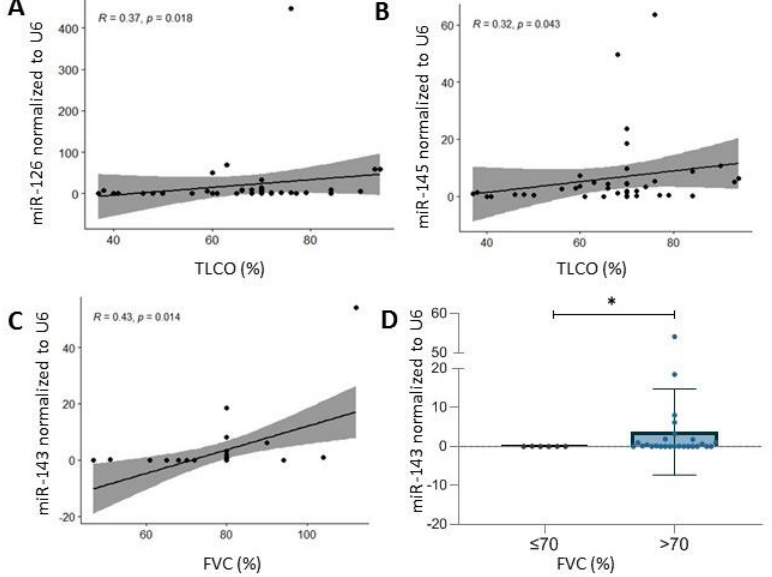
Figure 4. ( A ) Correlation between transfer factor for carbon monoxide (TLCO) and serum miR-126 level in systemic sclerosis patients. ( B ) Correlation between TLCO and serum miR-145 level in systemic sclerosis patients. ( C ) Correlation between forced vital capacity (FVC) and serum miR-143 level in systemic sclerosis patients. ( D ) miR-143 expression level in systemic sclerosis patients with forced vital capacity (FVC) equal to or below 70% and above 70%. Data are presented with the mean as a scatter dot plot; * p <